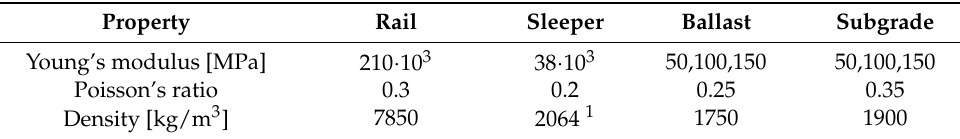
Table 1. Elastic material properties for the three-dimensional railway model. Property Rail